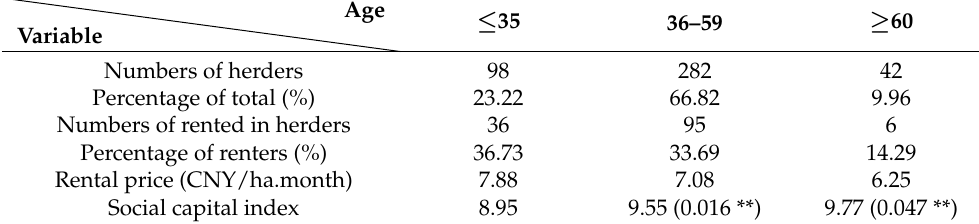
Table 5. Herders’ grassland rental market participation related